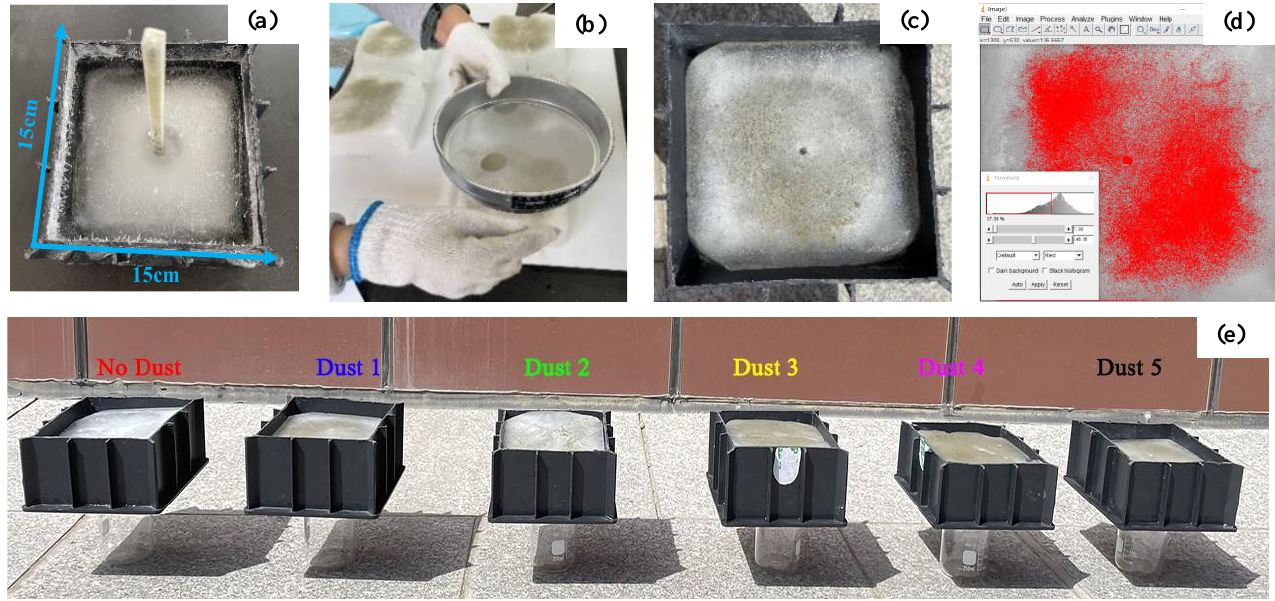
Figure 6. Ice melting physical experiment. ( a ) Ice mold. ( b ) Dust preparation. ( c ) Dust cover. ( d ) Dust coverage calculation. ( e ) Outdoor melting.